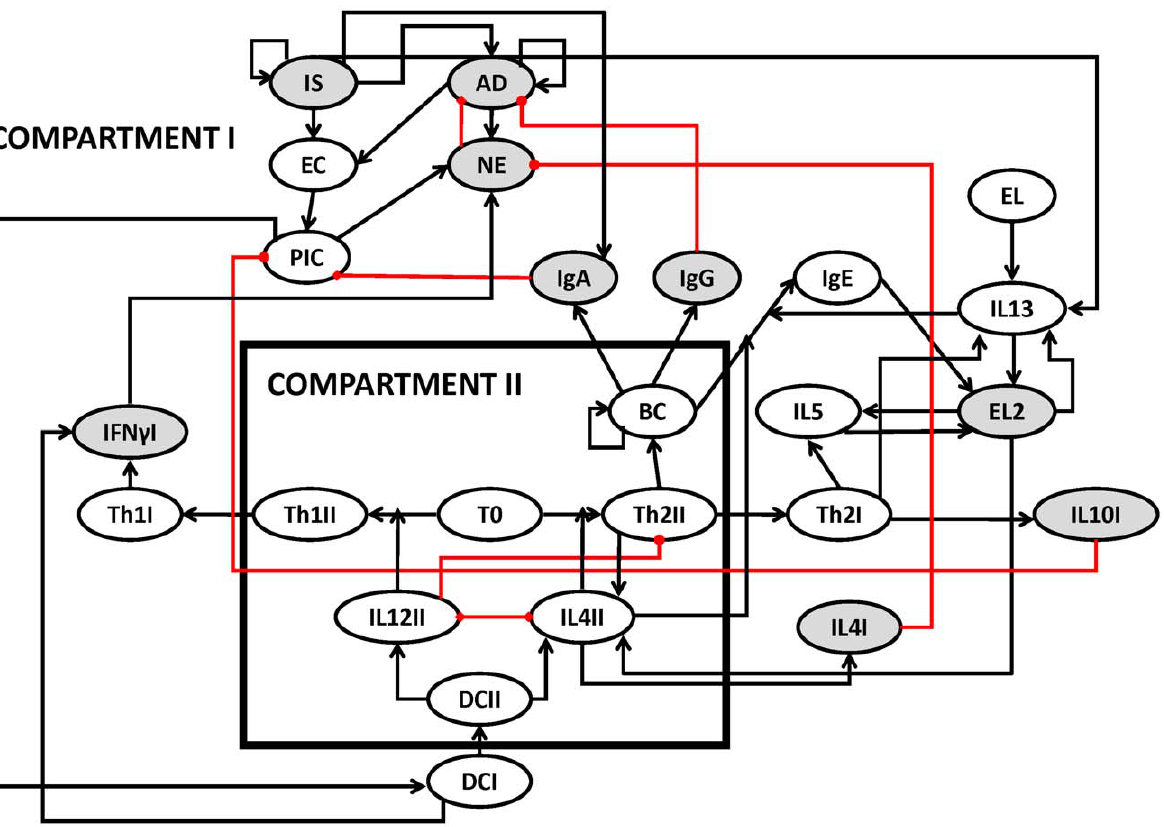
Figure 2. Network of immune components considered in single T.retortaeformis infection. Grey nodes have been quantified in the single laboratory experiment. Abbreviations: IS : Larvae; AD : Adult; IL4II : Interleukin 4 in the systemic compartment; NE : Recruited neutrophils; IgA : Antibody A; IL4I : Interleukin 4 in the small intestine; Th2II : Th2 cells in the systemic compartment; Th2I : Th2 cells in the small intestine; IgG : Antibody G; IgE : Antibody E; IL10I : Interleukin 10 in the small intestine; IFN c I : Interferon gamma in the small intestine; IL12II : Interleukin 12 in the systemic compartment; BC : B cells; DCII : Dendritic cells in the systemic compartment; DCI : Dendritic cells in the small intestine; Th1I : T helper cells subtype I in the small intestine; PIC : Pro-inflammatory cytokines; Th1II : T helper cells subtype I in systemic compartment EC : Epithelial cells the small intestine; T0 : Naı¨ve T cells; EL2 : recruited eosinophils; EL : resident eosinophils; IL13 : Interleukin 13; IL5 : Interleukin 5. Additional details in Figure 1.